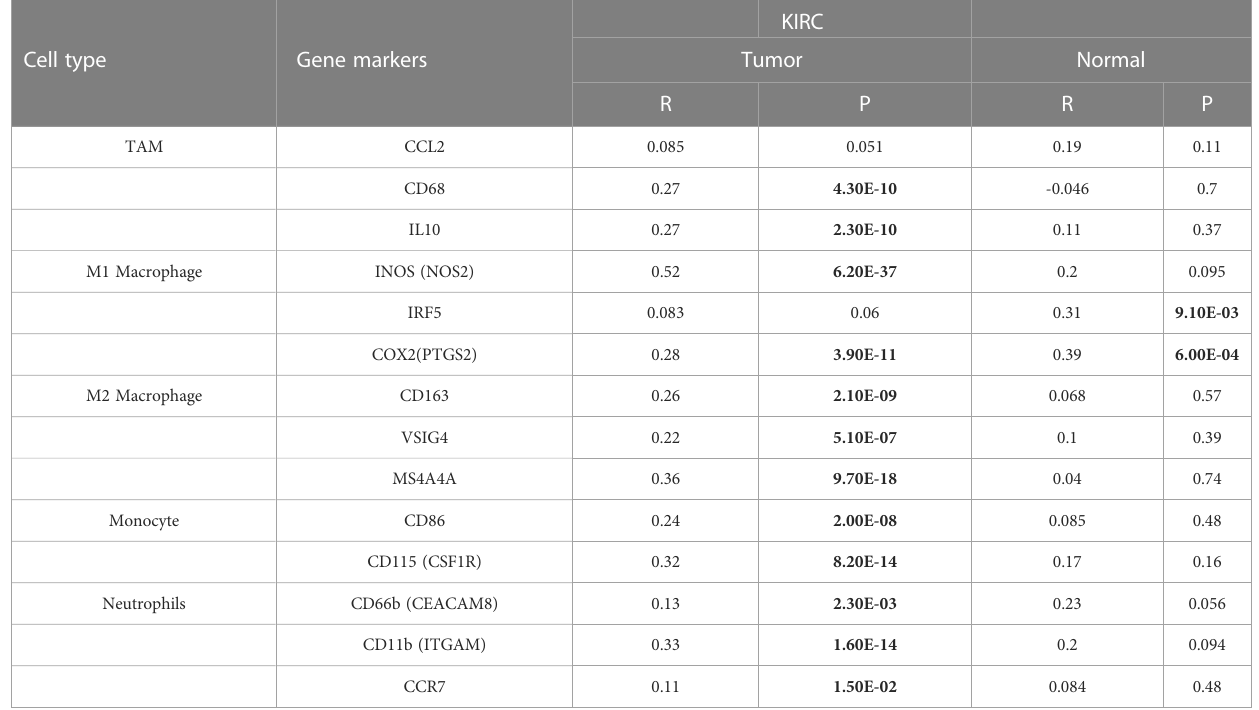
TABLE 3 Correlation analysis between PIK3C2A and gene markers of immune cells in GEPIA.